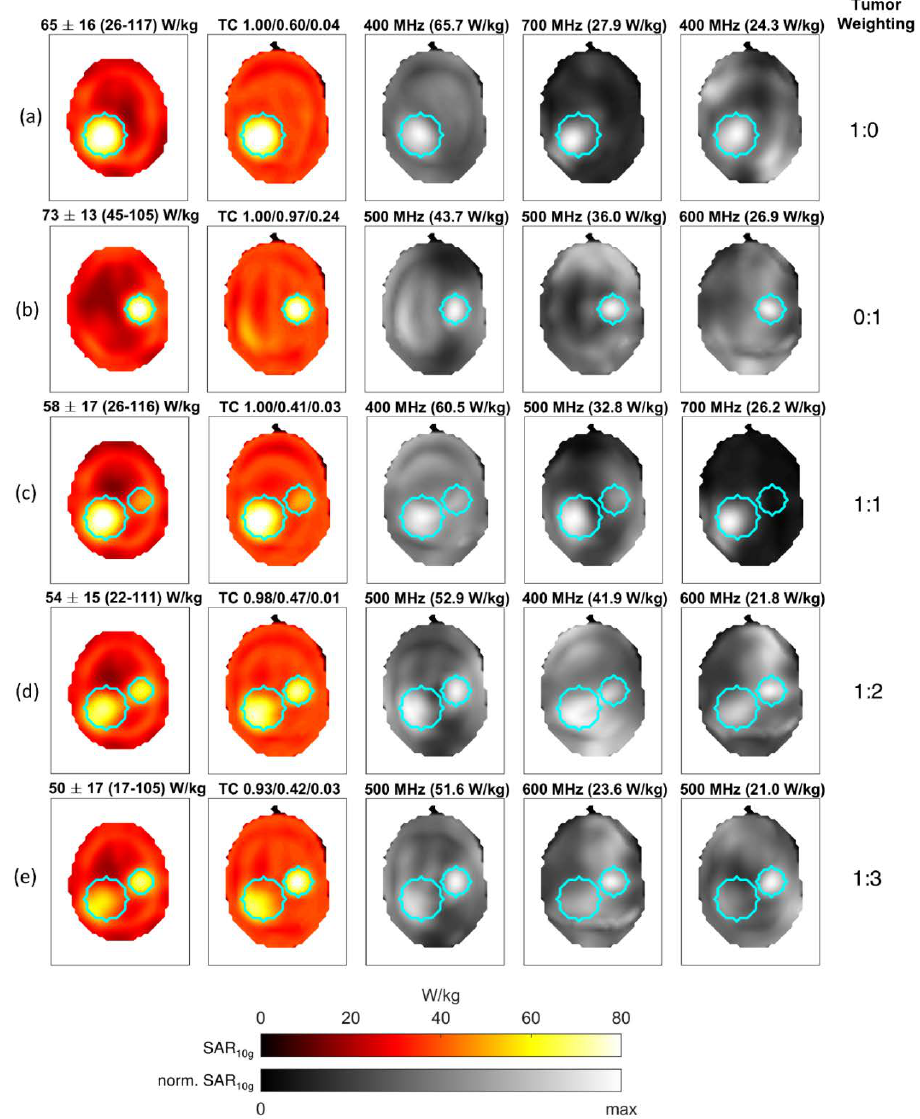
Figure 7. Results for the di ff erently weighted two-tumor optimization. The leftmost image column displays axial slices through the target center; all other images are axial maximum-intensity projections with the results for individual contributing frequencies and modes being scaled to their individual maximum that is stated above them along with the frequency. Measures of SAR within the target region are detailed in the header (Mean ± SD (Min–Max)) along with TC25, TC50, and TC80 values for the tumor. Targeting each tumor separately leads to SAR patterns shown in ( a ) and ( b ). From ( c ) to ( e ), the weight of the smaller tumor increased from an equal to threefold weighting. Due to their di ff erent sizes, the target voxels belonging to the smaller tumor require a higher relative weighting for an approximately equal SAR